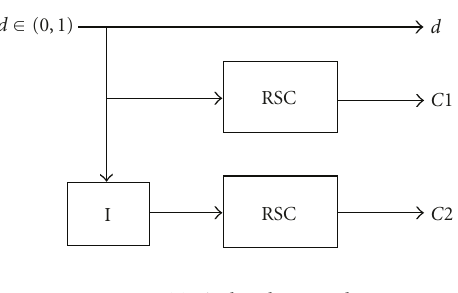
Figure 1: Typical turbo encoder.